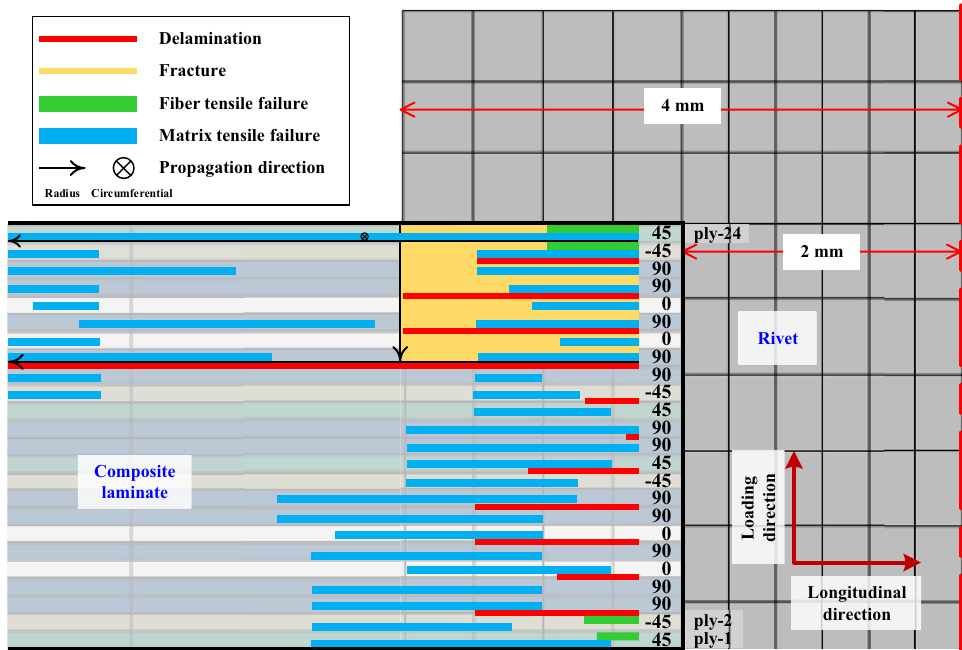
Figure 9 Schematic illustration of dominant failure modes and their locations in laminate